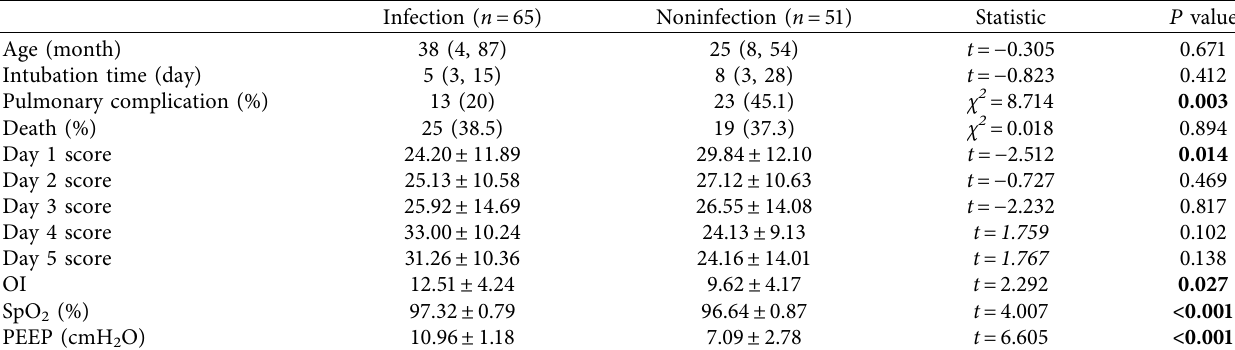
Table 2: Comparison of infection and noninfection groups.